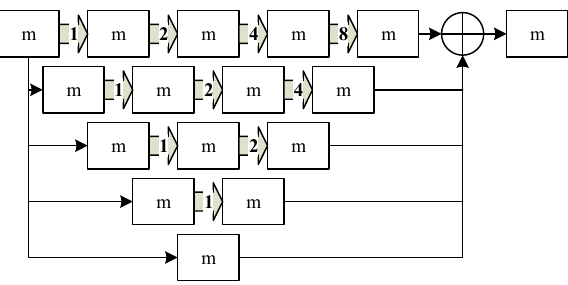
Figure 8. The construction of